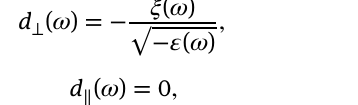
applying the mesoscopic boundary conditions, Eq.